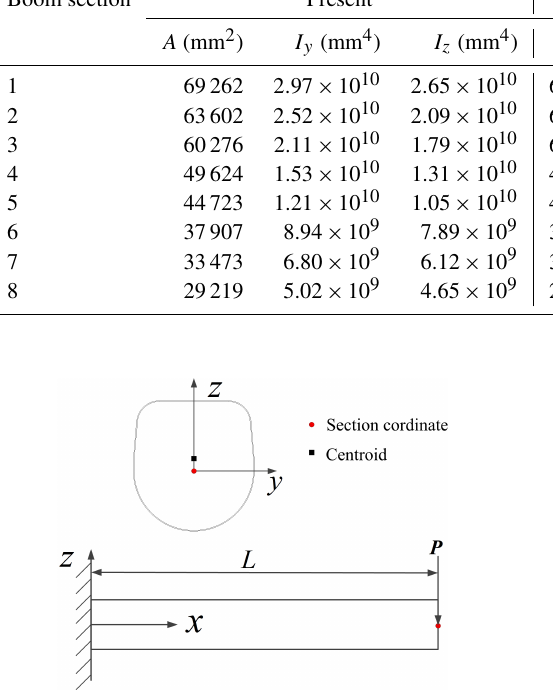
Table 2. Section parameters comparison of boom sections. Boom section